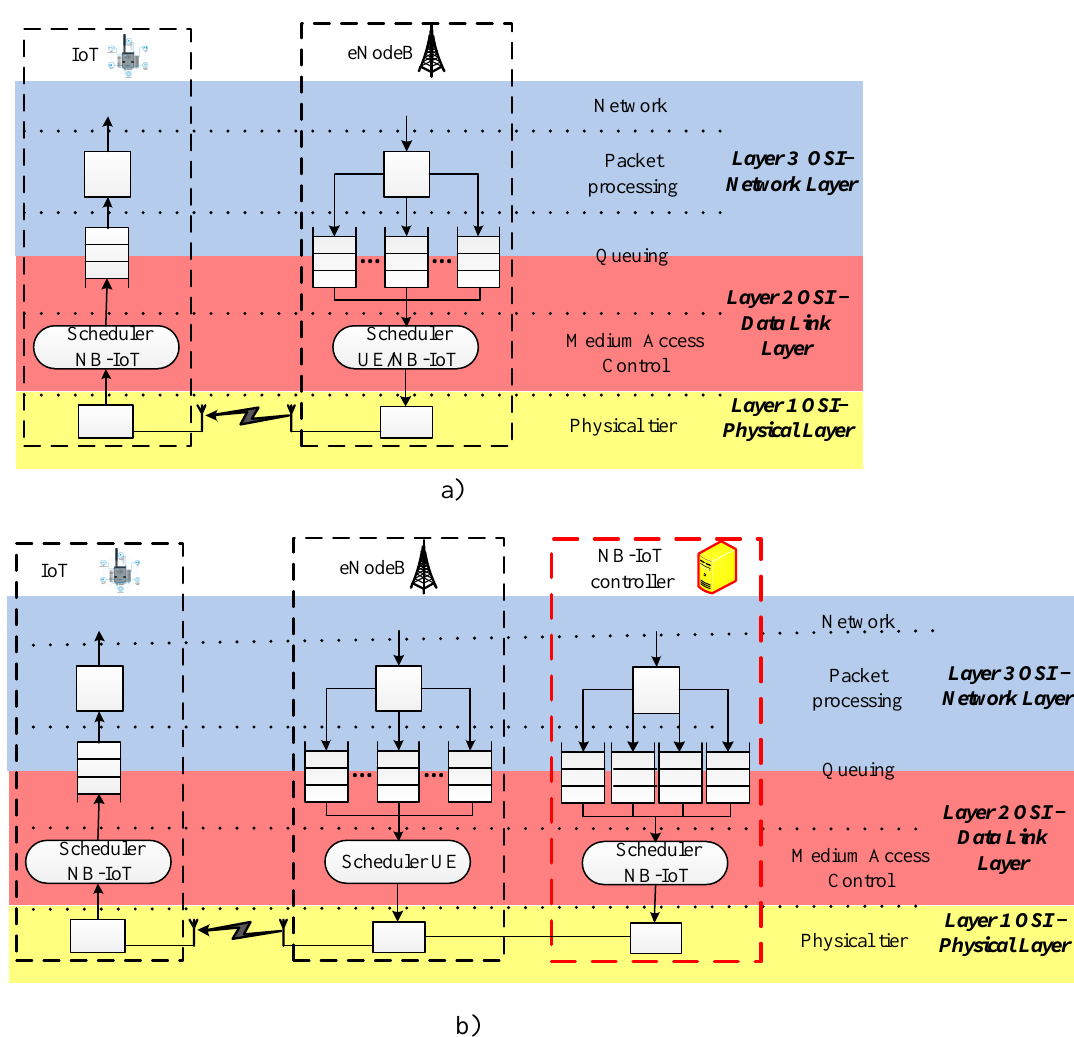
Figure 1. Classical Narrow-Band Internet of Things (NB-IoT) Architecture of 4G/5G base station interworking with IoT device ( a ), and the proposed NB-IoT architecture of interactions between 4G/5G base station, IoT controller and IoT device ( b ).